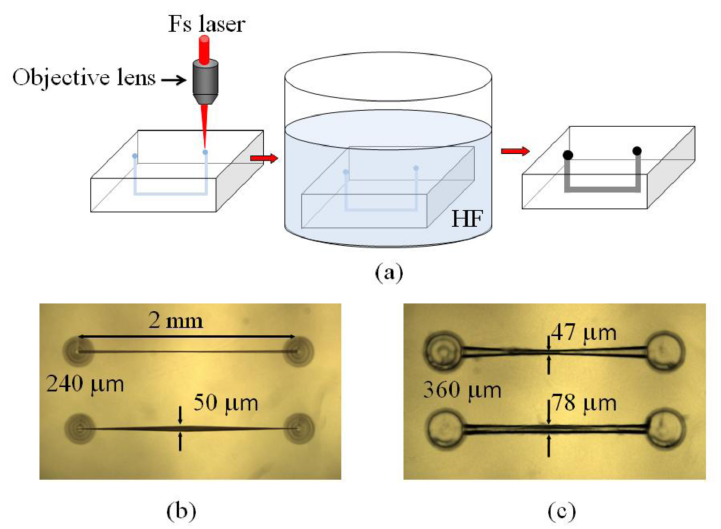
Figure 4. Femtosecond laser microfabrication of opto-microfluidic devices: ( a ) fabrication procedures, ( b ) U-shape-microchannels in fused silica before etching, and ( c ) after etching for 5 h in 20% HF acid within a shaker. Reprinted with permission from [75]. Copyright 2011,